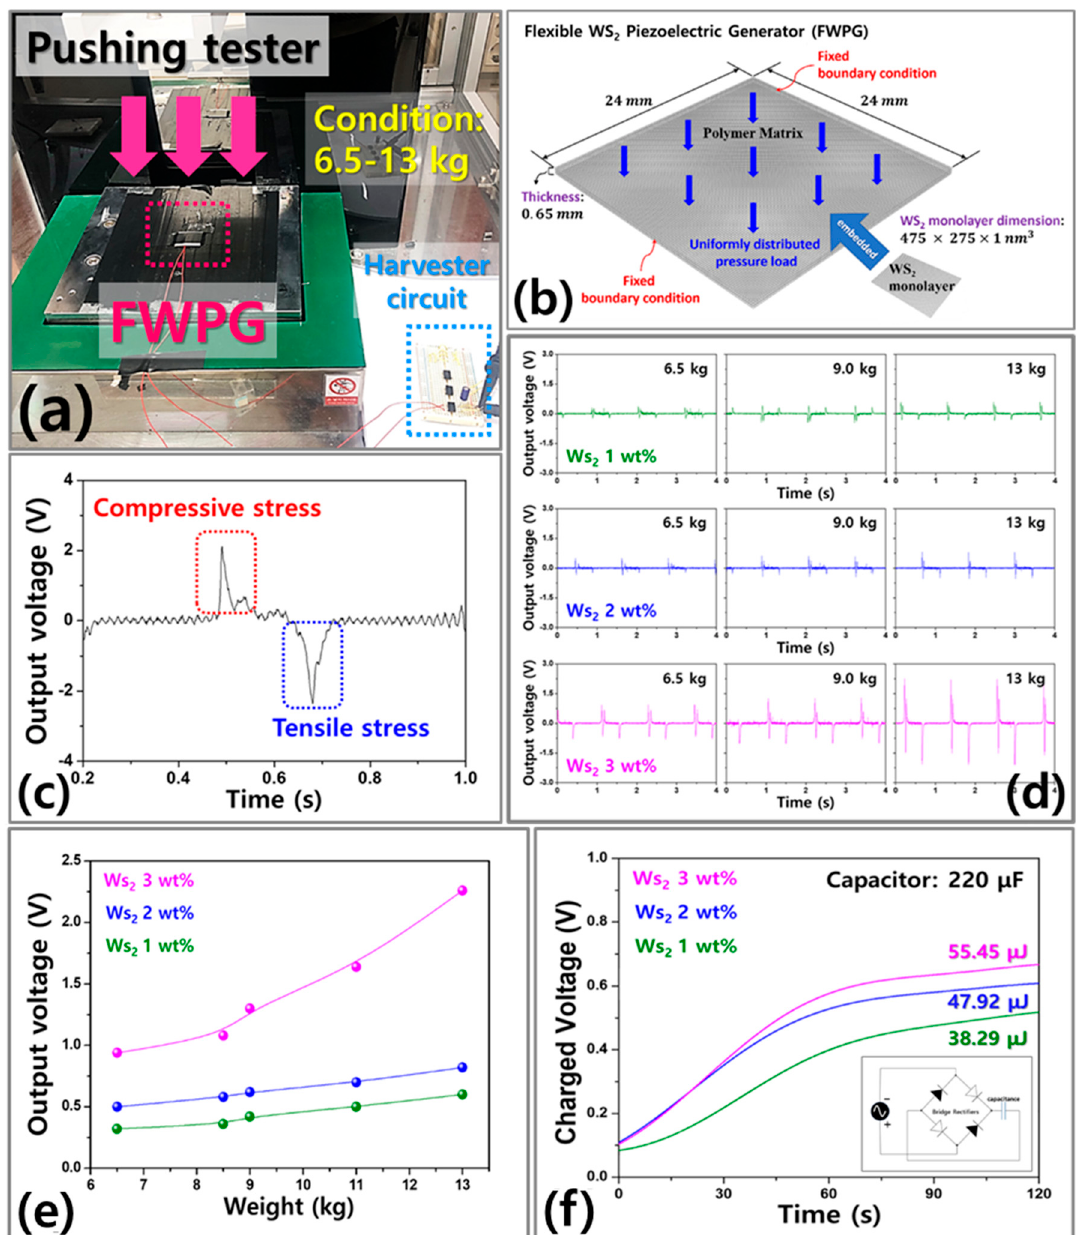
Figure 4. ( a ) Photograph of the experimental setup for energy harvesting performance using the pushing tester. ( b ) An illustration of the FWPG. ( c ) Output performance of compressive stress and tensile stress with the FWPG. ( d ) Output voltage (V) of the FWPG with various proportions of WS 2 and pressing conditions: WS 2 1 wt%, WS 2 2 wt%, and WS 2 3 wt%. ( e ) Maximum output voltage (V) of the FWPG with various proportions of WS 2 and pressing conditions. ( f ) Charged voltage (V) and energy ( μ J) of the FWPG with various proportions of WS 2 under periodic pressing by 13 kg.